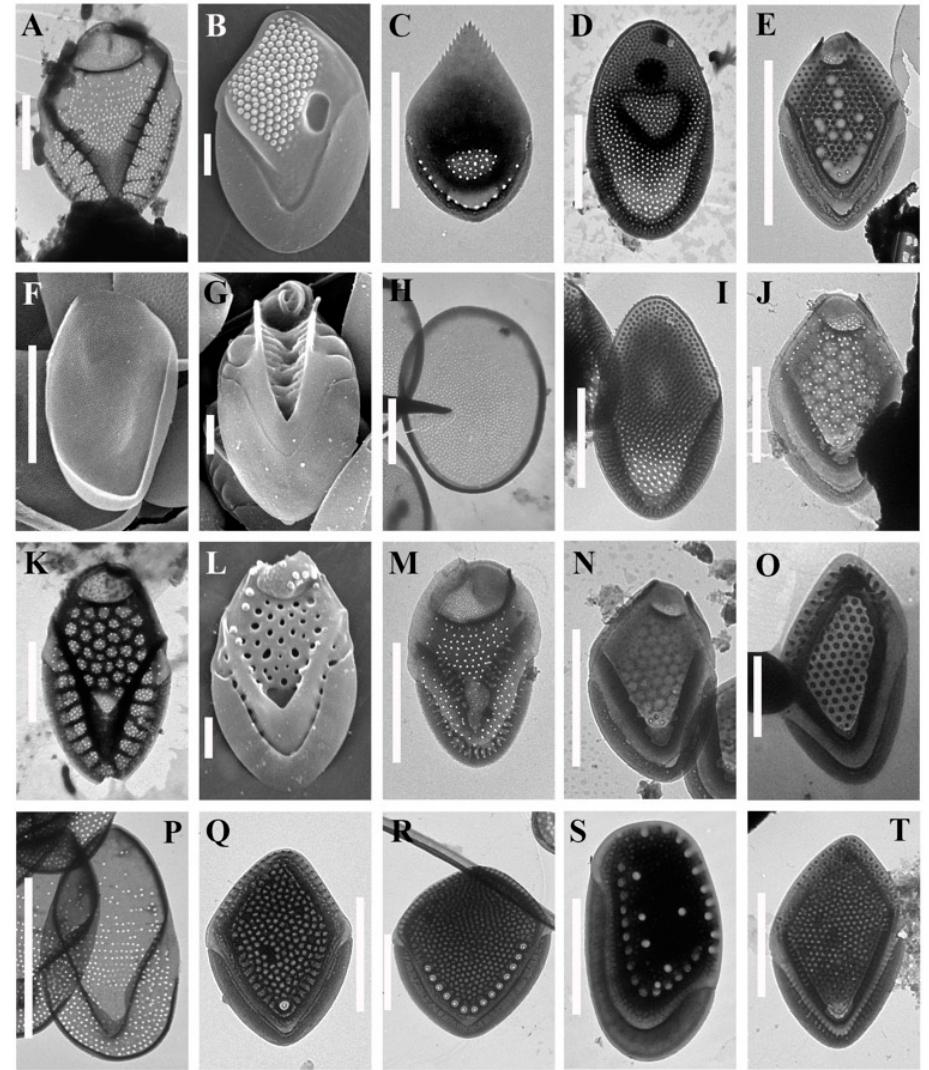
Figure 2. Scales of Mallomonas ( A ) M. acaroides . ( B ) M. adamas. ( C ) M. akrokomos . ( D ) M.